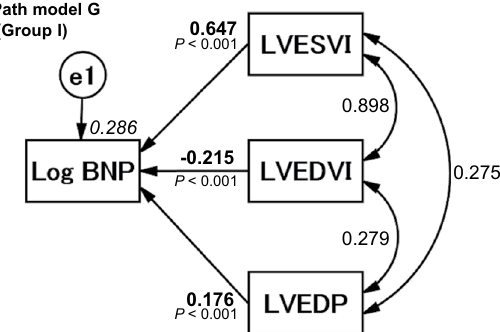
Figure 3. Path model G. The paths are displayed with the coefficients that indicate the standardized coefficient of the regressing independent variable on the dependent variable of the relevant path (path model G, LVESVI and/or LVEDVI and/or LVEDP to Log BNP) in Group I. These variables are the standardized regression coefficients (direct effect), squared multiple correlations [on the upper right side of rectangles (in italics)] and the correlations between each of the variables. Other variables included in the covariance structure analysis are presented in Supplemental Table 8. BNP, B-type natriuretic peptide; LVESVI, left ventricular end-systolic volume index; LVEDVI, left ventricular end-diastolic volume index; LVEDP, left ventricular end-diastolic pressure; and e, extraneous